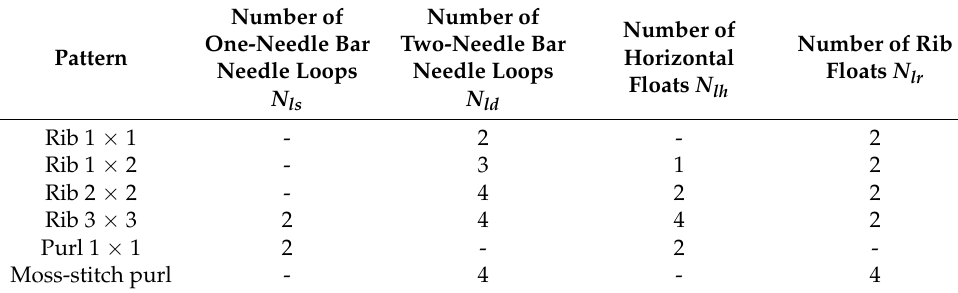
Table 2. Number of structural elements in pattern